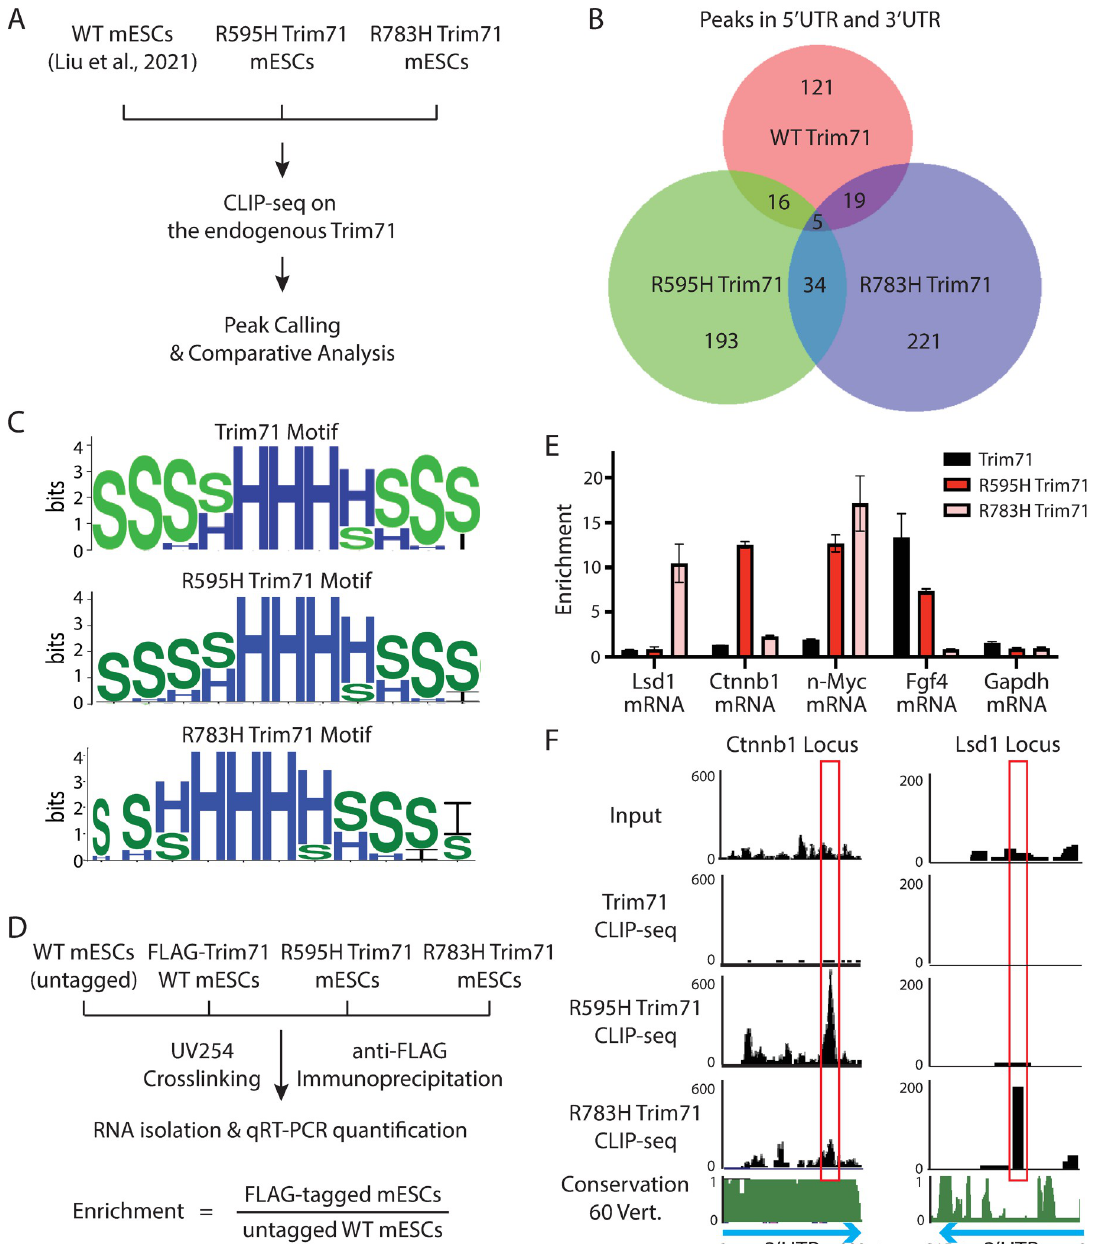
Fig 2. Comparative analysis of the transcriptome-wide target mRNAs of the WT Trim71 and the two Trim71 mutants in mESCs. ( A ) An outline of the comparative analysis on the CLIP-seq datasets. ( B ) Venn diagram showing mRNAs with binding sites from the WT Trim71 and the two Trim71 mutants. ( C ) Comparison of RNA secondary structures overrepresented in the WT Trim71 and the two Trim71 mutants. “H,” “S,” and “I” indicate a nucleotide in a hairpin loop region, a stack region, and an internal loop region, respectively. ( D ) A workflow of the CLIP-qRT-PCR to validate the target mRNAs identified from the CLIP-seq experiments. ( E ) CLIP- qRT-PCR for the identified target mRNAs of the two Trim71 mutants. The results represent the means ( ± SD) of three independent experiments from the cells cultured in the 2i + Lif medium. ( F ) UCSC genome browser snapshot for the CLIP-seq datasets from the WT Trim71 and the two Trim71 mutants in the 3 0 UTRs of the Ctnnb1 and Lsd1 . The red boxes indicate the binding regions of the Trim71 mutants. The inputs are from the size-matched input samples in the CLIP-seq analysis. The conservation score determined from the genome sequences of 60 vertebrates is from the default track of the UCSC genome browser. See also S5 Fig and S1 Table. The data for E are available in S2 Data. CLIP-seq, crosslinking immunoprecipitation and sequencing; mESC, mouse embryonic stem cell; qRT-PCR, quantitative real-time PCR; WT, wild-type.